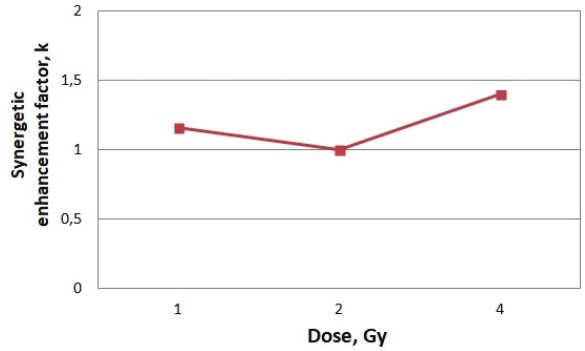
Figure 2. Synergetic enhancement factor k as a function of dose for the HeLa cell line.